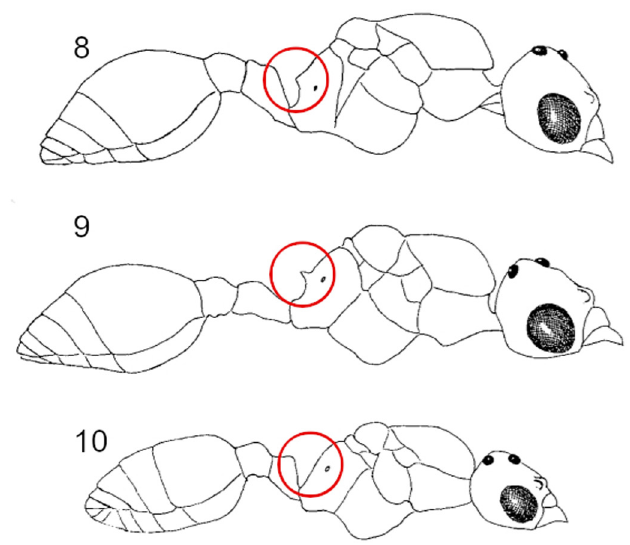
Figs 8–10. Lateral view of male specimens of Temnothorax Mayr, 1861 from Algeria with a focus on the propodeum, drawings from Cagniant (1970). 8 . T. curtulus (Santschi, 1929), dentiform propodeal spines. 9 . T. gentilis (Santschi, 1923), well-developed propodeal spines. 10 . T. tebessae (Forel, 1890), no propodeal